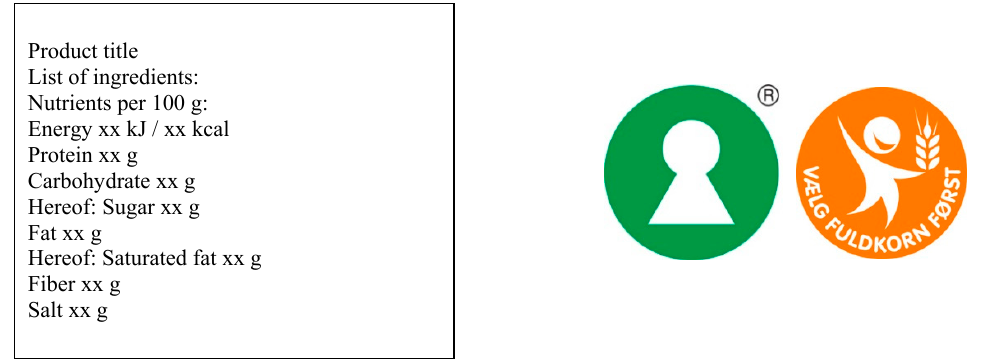
Figure 1. Example of Description of Content (DoC) (left) and nutritional labels (NL): the Keyhole and Whole Grain labels (right). Note: Pictures from [45,46].